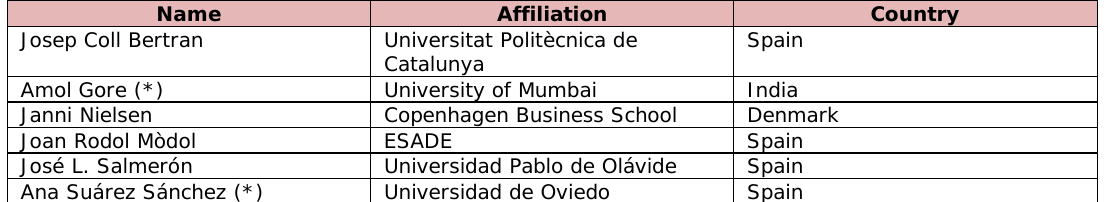
Table 4. “List of members of JIEM editorial board in 2009 (Information Systems, Technology and Communication). Members added in 2009 are marked with asterisk”. Source: